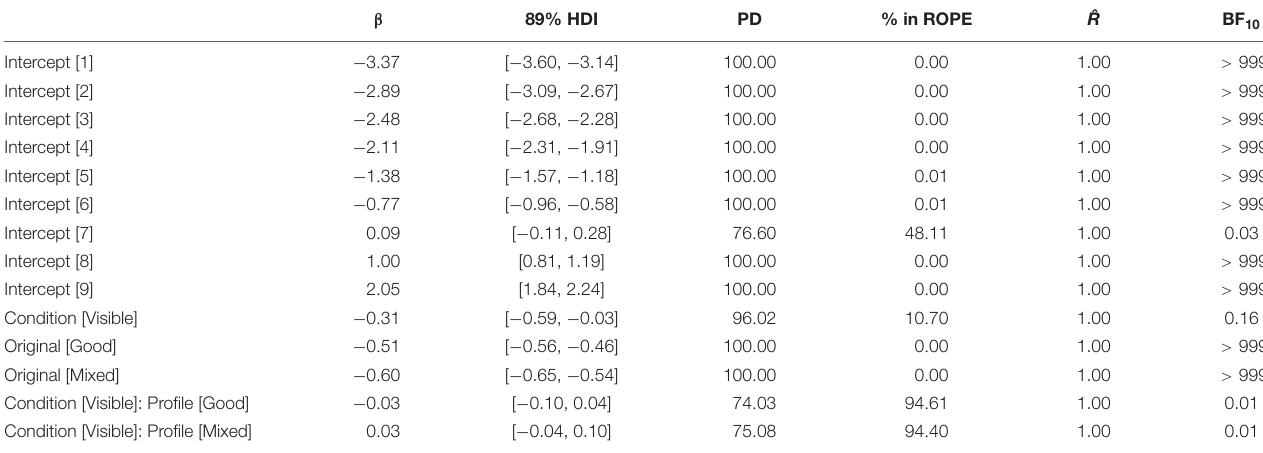
FIGURE 7 | Marginal effects of trustworthiness. The posterior mean estimates of the probability of responses in each of the three Profiles (Bad, Good, Mixed) by the two experimental Conditions (Reveal or Visible). Error bars indicate 95% credible intervals. TABLE 7 | Summary of the model fitted to the credibility ratings, considering the experimental condition (Visible or Reveal) and Profile type (Good, Mixed, and